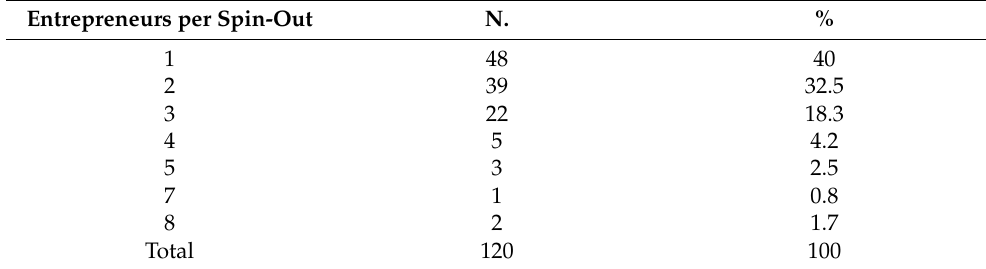
Table 1. Number of entrepreneurs per spin-out company (N. spin-outs: 250). Entrepreneurs per Spin-Out